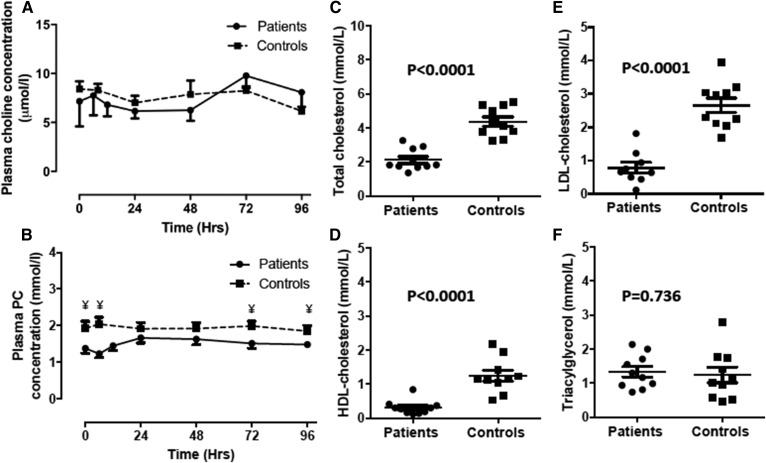
Plasma concentrations (mmol/l) of choline (A), PC (B), total cholesterol (C), HDL-cholesterol (D), LDL-cholesterol (E), and triacylglycerol (F) between ARDS patients and healthy controls. Plasma choline and PC were measured for the duration of the investigative period (4 days). Cholesterol and triacylglycerol concentrations are at time t = 0 on day 1. Error bars indicate SEM. Statistical analysis unpaired Student’s t-test. ¥, P < 0.05.